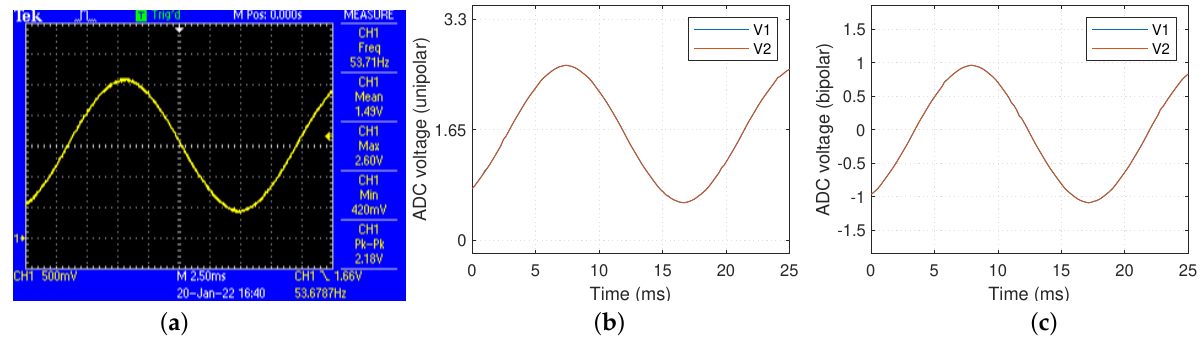
Figure 19. ADC voltage visualization using Simulink external mode with the demo model. ( a ) Sine wave applied to the ADCs. ( b ) ADC voltages read in unipolar mode. ( c ) ADC voltages read in bipolar